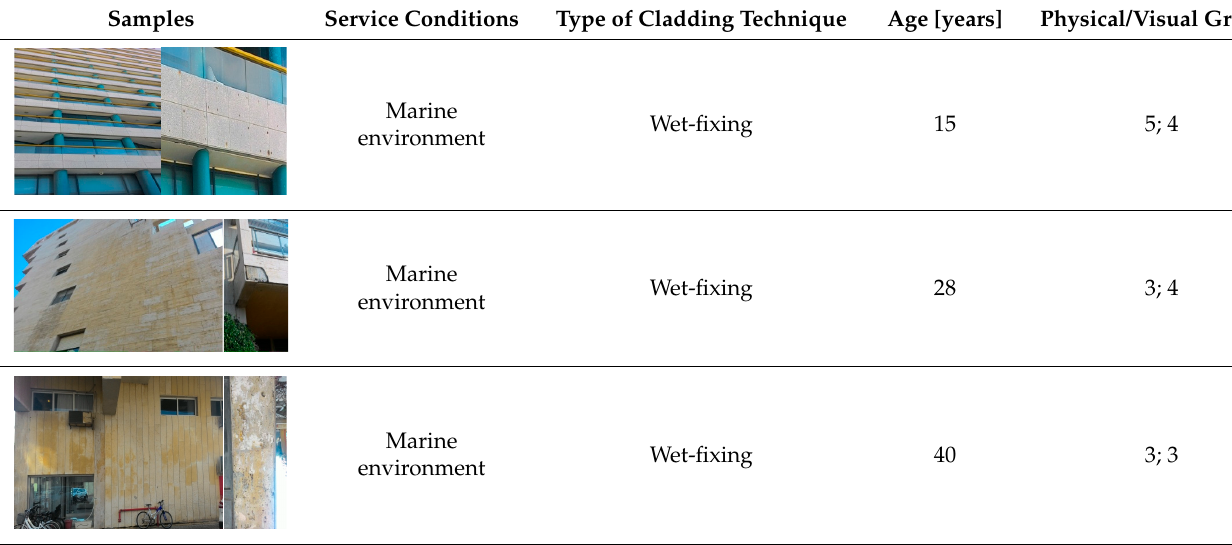
Table 4. Characteristics of three wet-fixed stone claddings observed in marine environment.